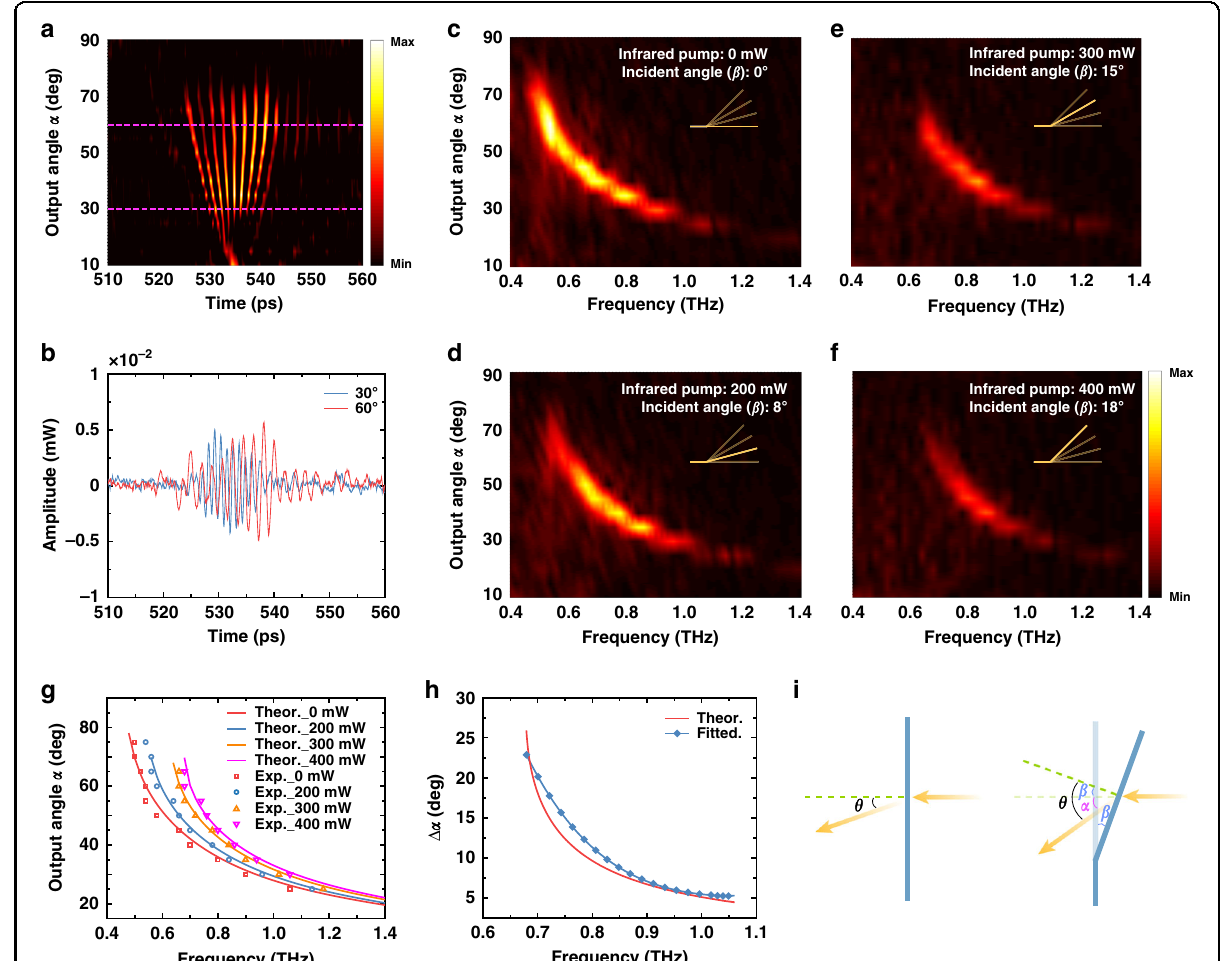
Fig. 3 Infrared regulation of the LCE sample. a Received time-domain signals at varied output angles. b Time-domain signals received at output angles of 30° and 60°. c – f Fourier transform of the received time-domain signals under 0, 200, 300, and 400 mW infrared pump. The insets indicate the de fl ection of the LCE sample. g The frequency-resolved output angles at each pump power. The solid lines show the output angles predicted by the generalized Snell ’ s law and the hollow square, circle, and up-and-down triangles are the measured ones. h Output angle variations ( Δ α ) at different frequencies between no pump and 400 mW pump. The red line was theoretically calculated, and the blue dotted line is the fi tted results of the measured data. i In fl uence of the LCE substrate de fl ection on the refraction of terahertz